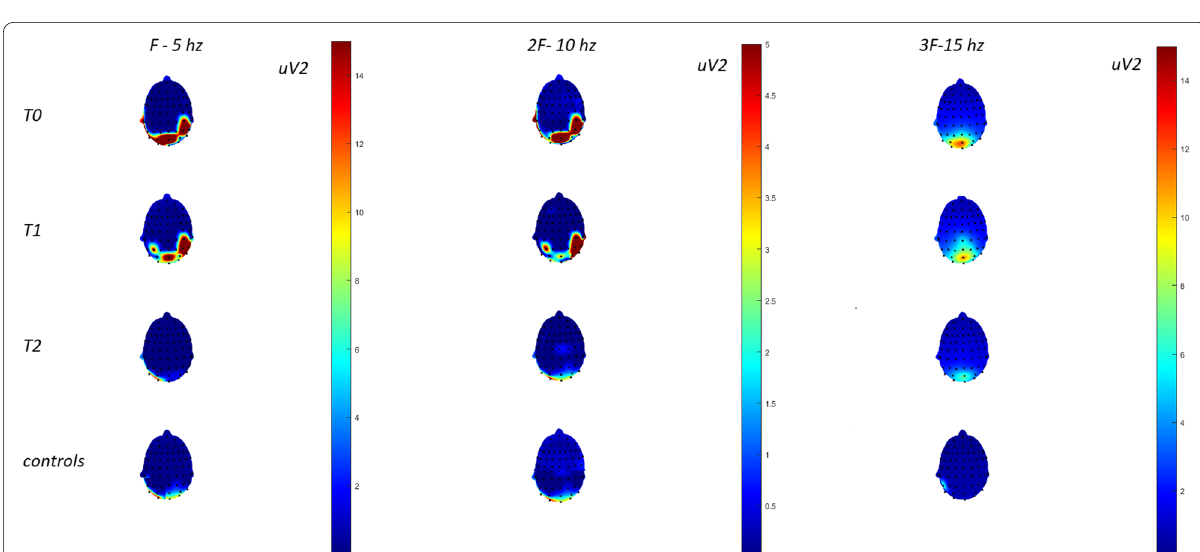
Fig. 6 Topographic representation of SSVEPs in F (5 Hz), 2F (10 Hz) and 3F (15 Hz) in migraine patients (13 cases) at T0,T1 and T2 and controls (10 cases). The color map scale, emphasizes the prominence of spectral power in migraine patients at